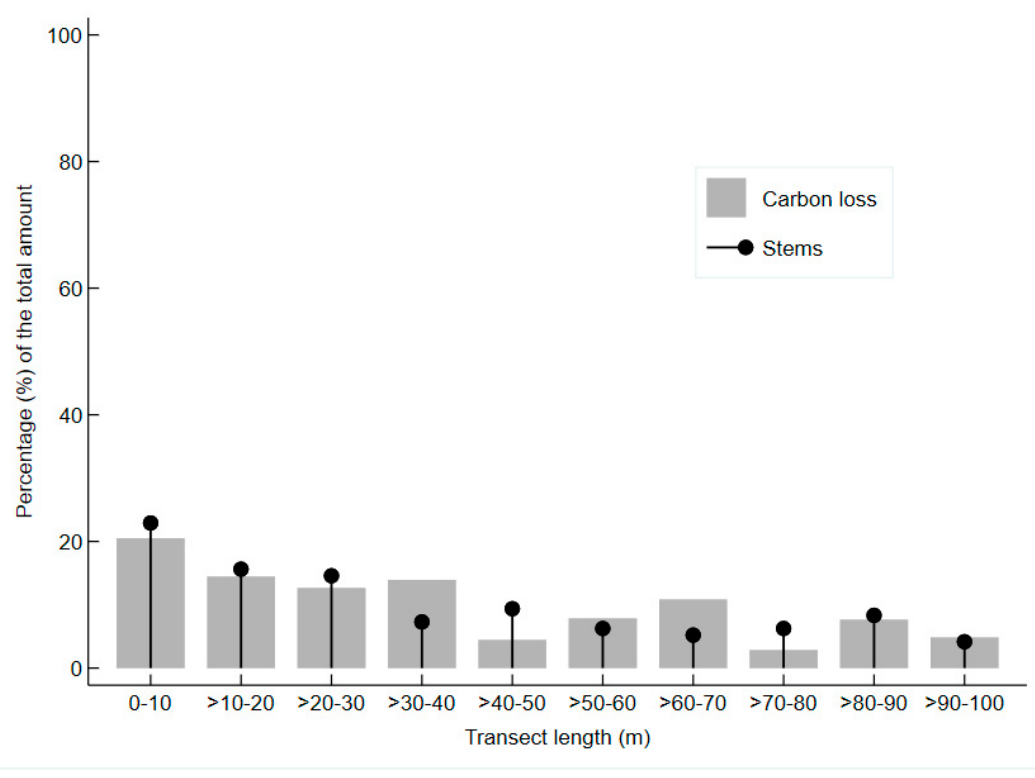
Figure 4. Distribution of stems and carbon loss from mining degradation damage at 10 m interval as a percent of all mining damaged trees and total carbon loss along the 100 m length of the fixed-area transects.